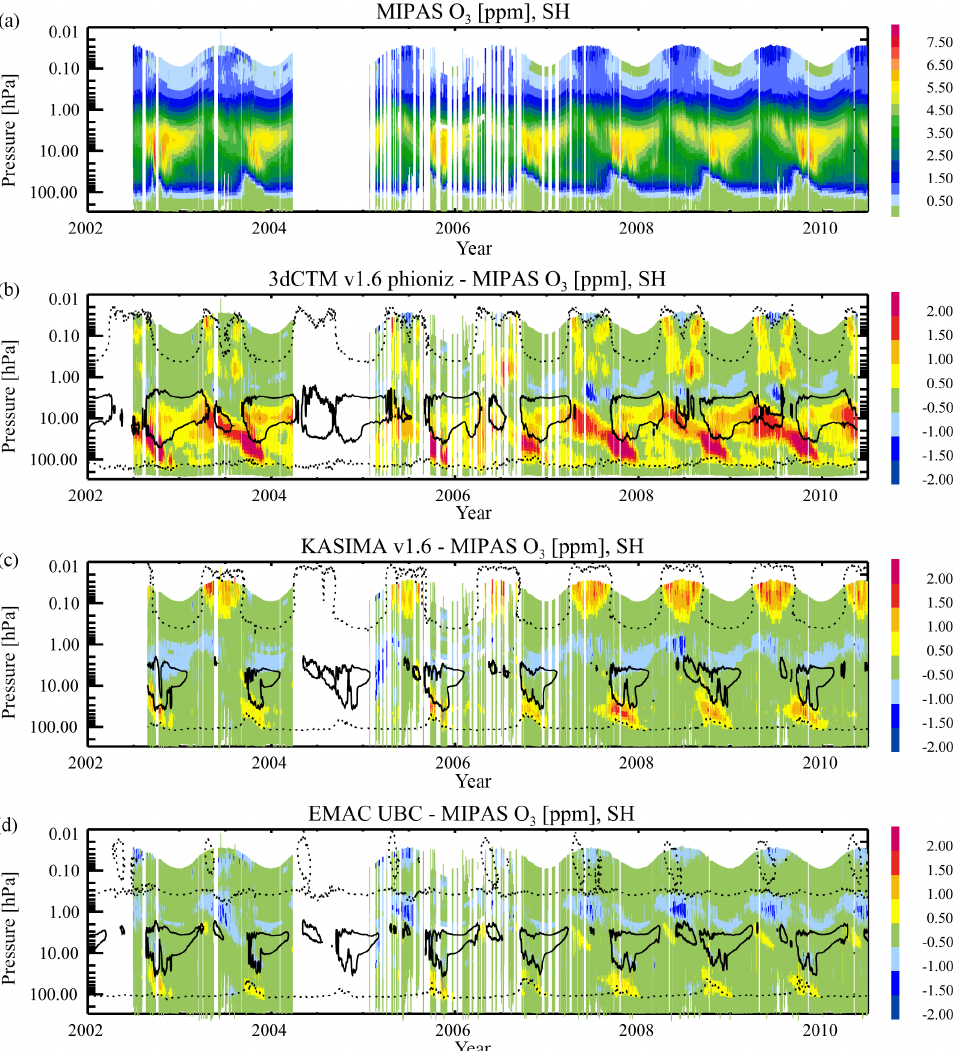
Figure 8. Comparison of ozone time series at high southern (70–90 ◦ ) latitudes from MIPAS observations with model results including full particle forcing (3dCTM v1.6 phioniz, KASIMA v1.6, EMAC UBC). From top to bottom: MIPAS ozone mixing ratios (ppm), difference of 3dCTM, KASIMA and EMAC mixing ratios to MIPAS mixing ratios (ppm). Solid and dotted black lines are the 1 and 0.5ppm contours of the model